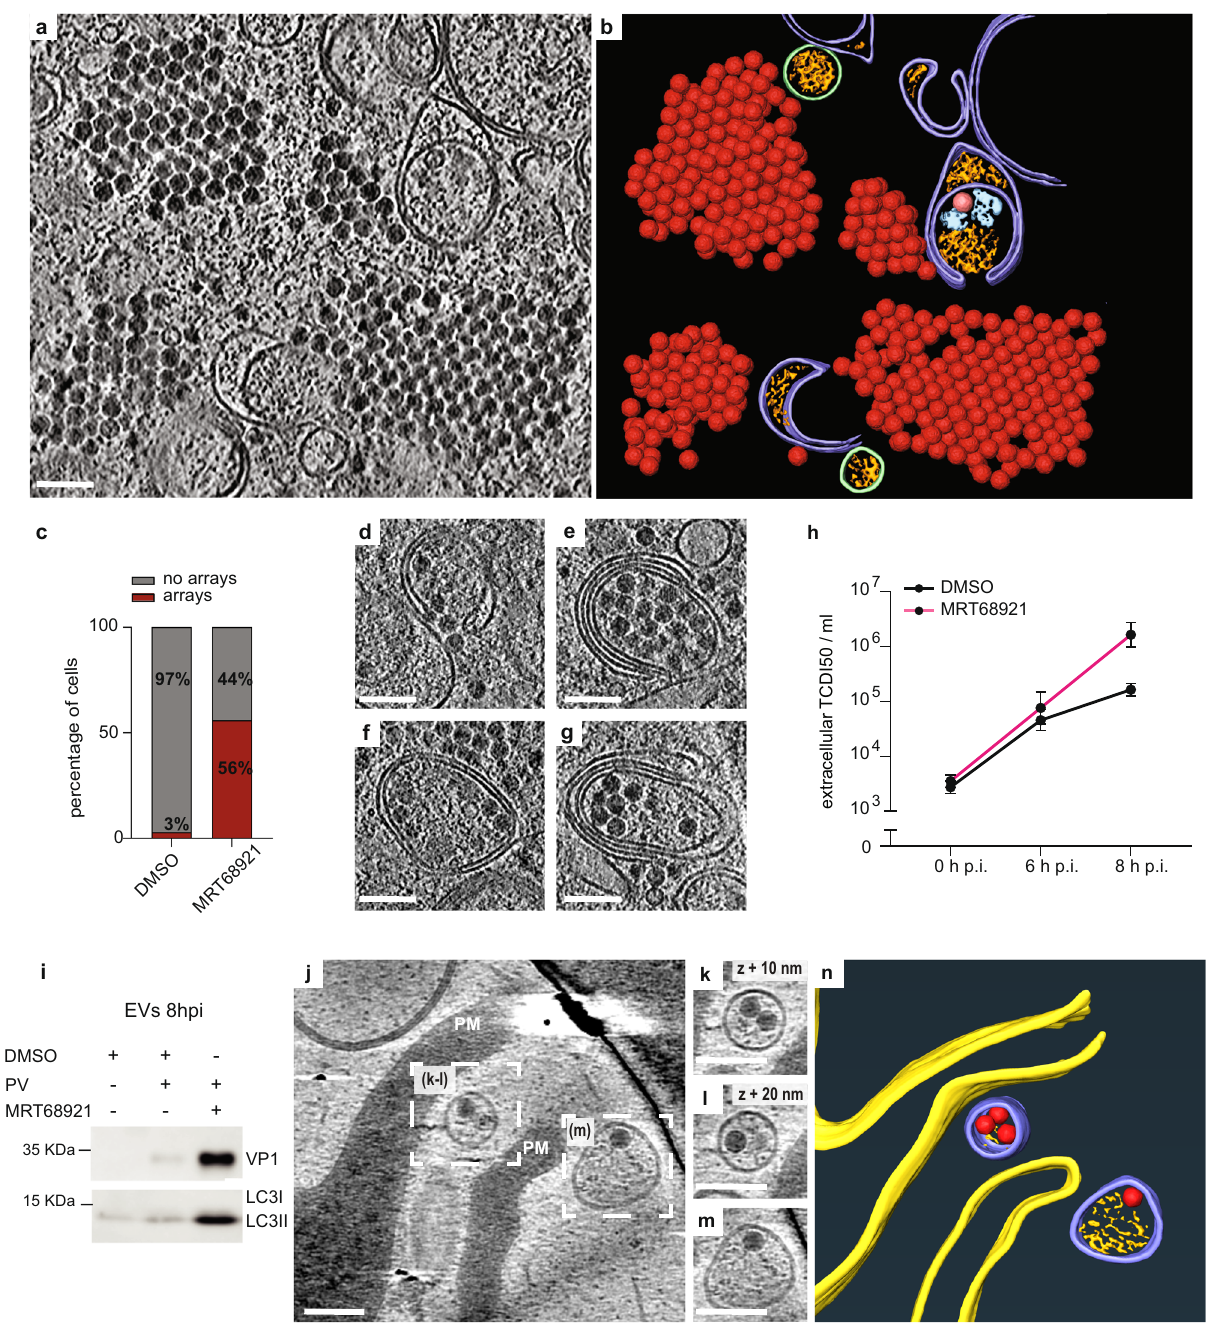
Fig.4 |InhibitionofULK1/ULK2inducesformationofintracellularvirusarrays and increases infectious virus release. a Cryo-electron tomogram of an MRT68921-treated, PV-infected cell containing cytoplasmic virion arrays. b Segmentation of the tomogram in ( a ). Virions are represented by their sub- tomogram averages. Colors are as in Fig. 1b. c Percentage of cells containing virus arrays in DMSO and MRT68921-treated cells as measured from freeze-substituted sections. d – g Several examples of virion recruitment to ALMs in tomograms of MRT68921-treated, PV-infected cells. h Time course of PV release from MRT68921